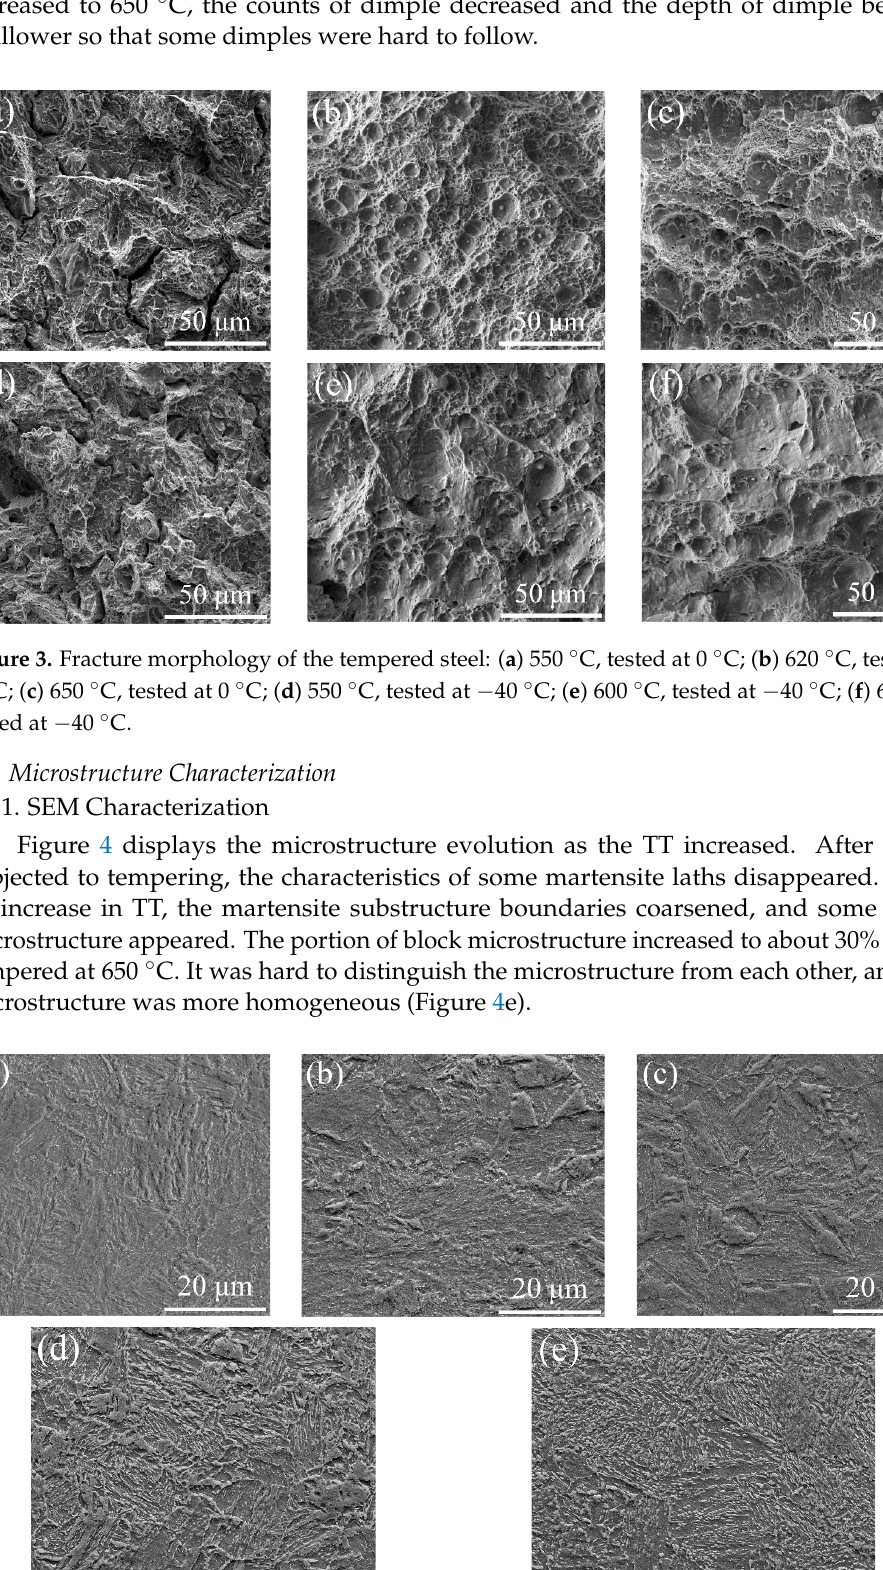
Figure 2. Mechanical properties after tempered at different temperatures: ( a ) strength and plasticity and ( b ) impact energy.